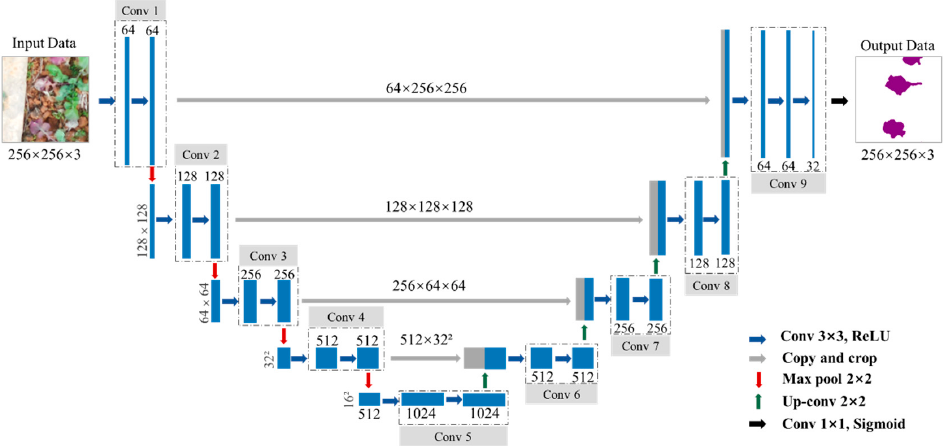
Figure 2. The architecture of the U-Net model used in this study with an input sample size of 256 × 256 pixels as an example. Each box represents the feature maps with the dimension of width × height on the left. For Conv 1, it performs two convolution operations with a 3 × 3 convolutional kernel, the number of feature maps is 64 with the size of 256 × 256 pixels, and then the max-pooling with a kernel size of 2 × 2 is performed.